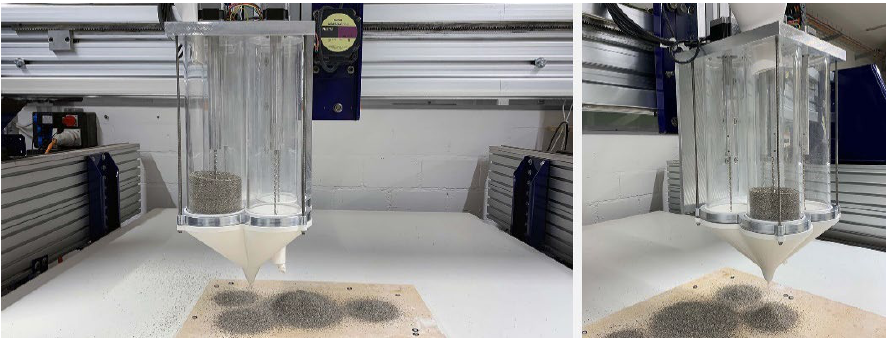
Fig. 4: CNC setup and multi-channel tool.